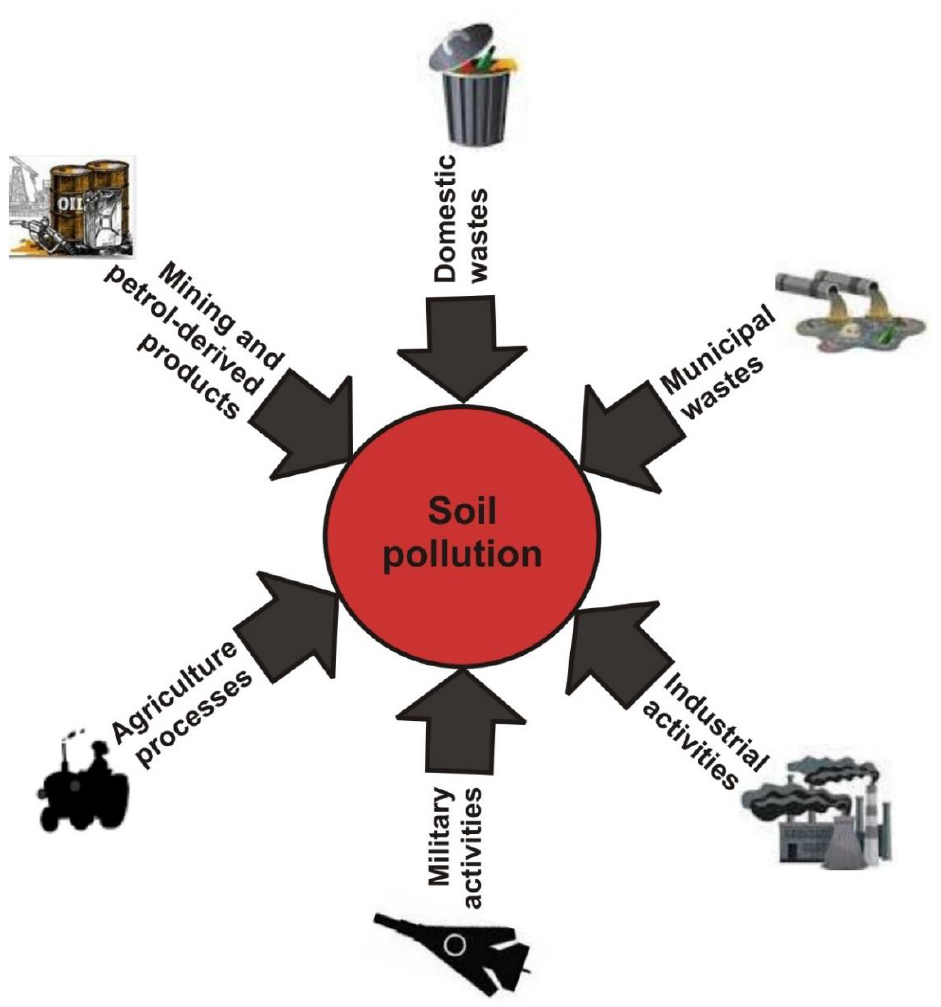
Figure 1. Main anthropogenic sources of soil pollution.